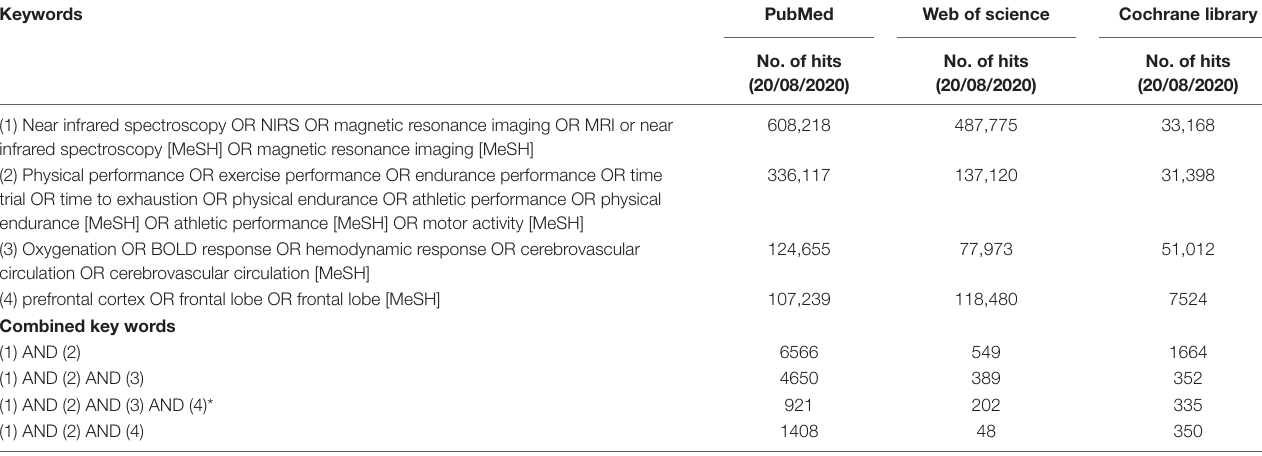
TABLE 2 | Search strategy: number of hits on keywords and combined keywords in PubMed, Web of Science, and Cochrane Library.